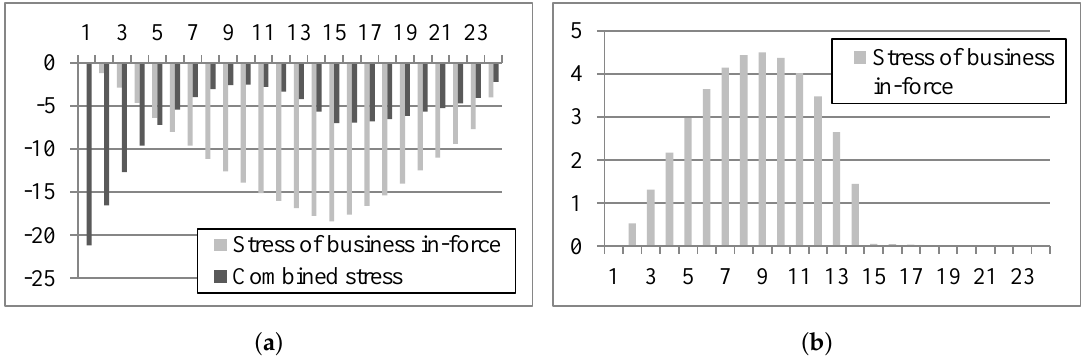
Figure 5. Change of pre-financing of uncovered acquisition costs over time for the lapse up and lapse down stress compared to the best estimate (in A C1000). ( a ) Lapse up stress; ( b ) Lapse down